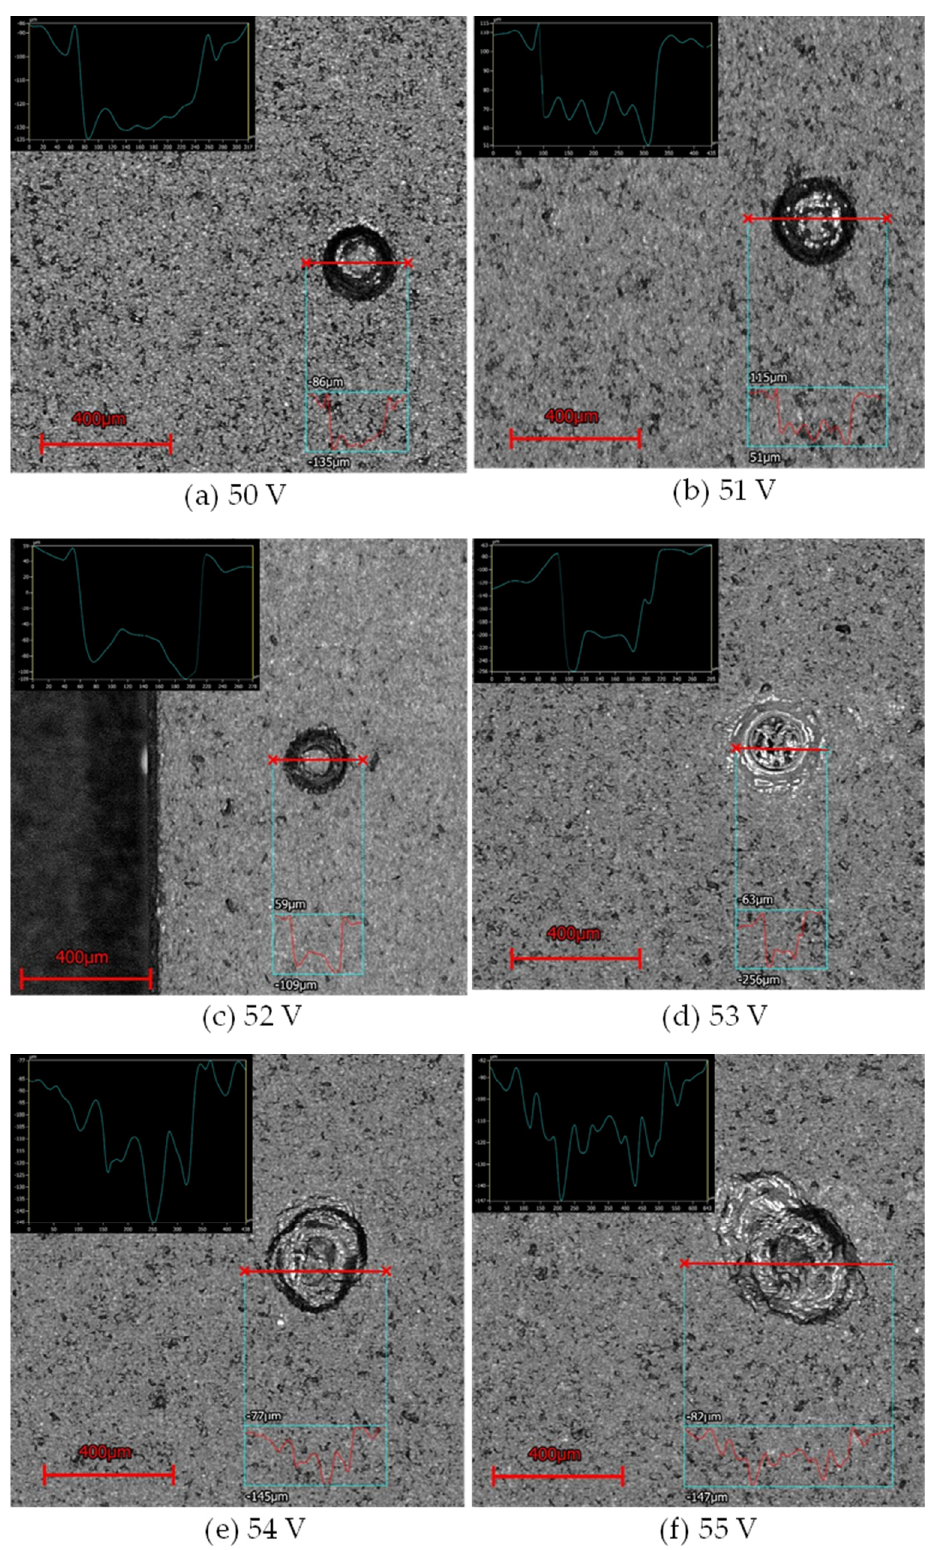
Figure 12. Cross sectional profile scan maps of sapphire holes machined and the hole measurement results obtained from the machining of sapphire glass with different machining voltages.